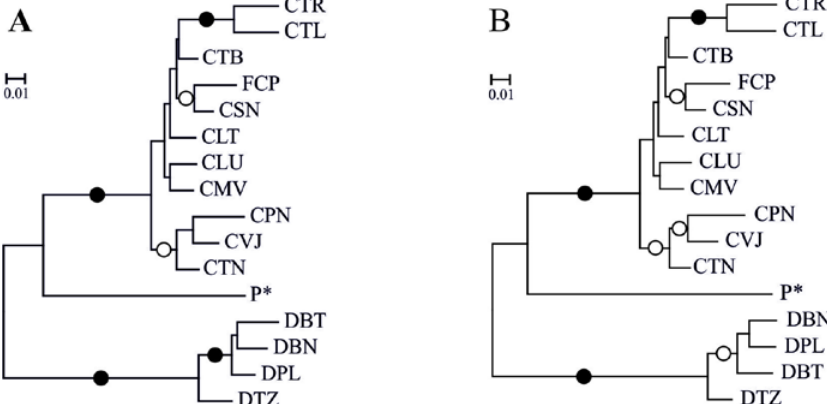
Figure 1. Unrooted neighbor joining tree of G. lutea populations obtained using pairwise Nei’s genetic distance ( A ) and the 1 − Q distance ( B ). P*, Pyrenees samples grouped. xy Black circles in nodes indicate bootstrap support ranging from 90% to 100%; White circles in nodes indicate bootstrap support ranging from 70% to 89%.